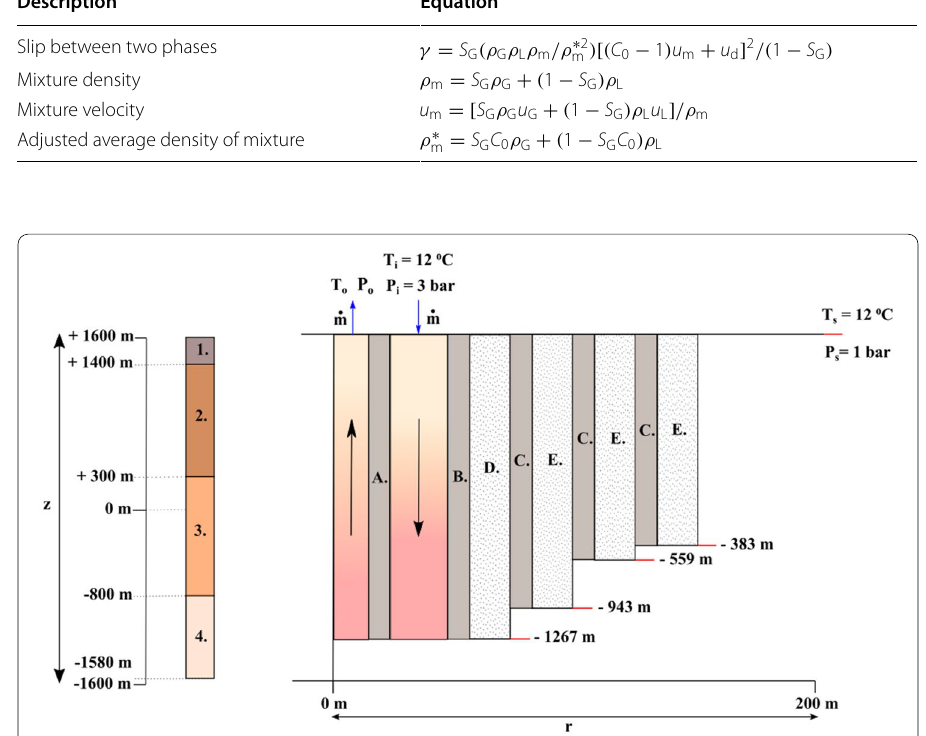
Fig. 2 Geological setting and well completion diagram of DBHE design implemented in T2Well/EOS1. Left— geological setup, with four key zones at defined depths in the z axis ( labels are supported by thermodynamic properties in Table 4. Right—2D asymmetric scheme containing 2752 cells in the r (1–200 m) and z axis, interpreted from Morita et al. (1992a), Sonnenthal et al. (2012). Well completion diagram of the DBHE interpreted from Cladouhos et al. (2016). Both depict the casing and cement sections at appropriate elevations in T2Well/EOS1, interpreted from Tang et al. (2019), Toth